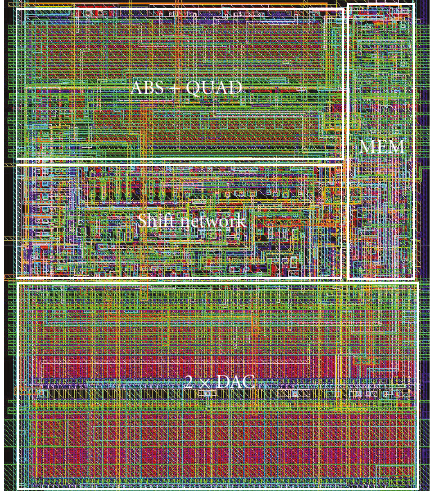
Figure 11: Layout of a single array cell with di ff erent functional sections